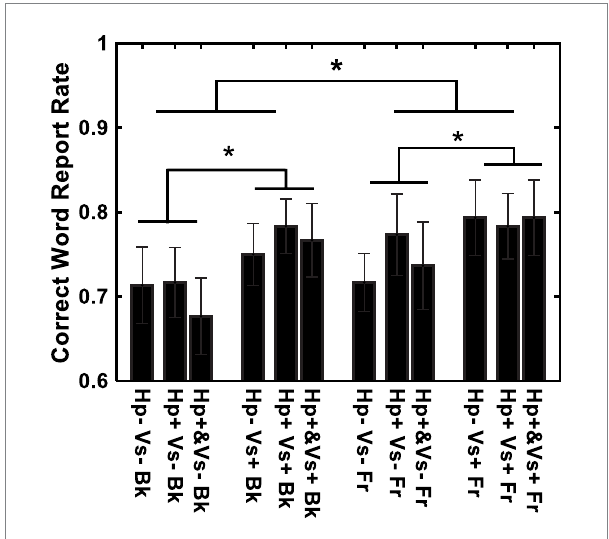
FIGURE 4 Recognition performance for individual conditions. Vs +: visual cue present with binocular stereopsis. Vs − : visual cue absent with monocular presentation. Hp+&: haptic cue to visual presentation. Hp+: haptic cue subsequently to visual presentation. Hp − : no haptic cue. Fr: virtual ribbon in front of the word. Bk: virtual ribbon as a hollow the word in the background. *: difference statistically significant.